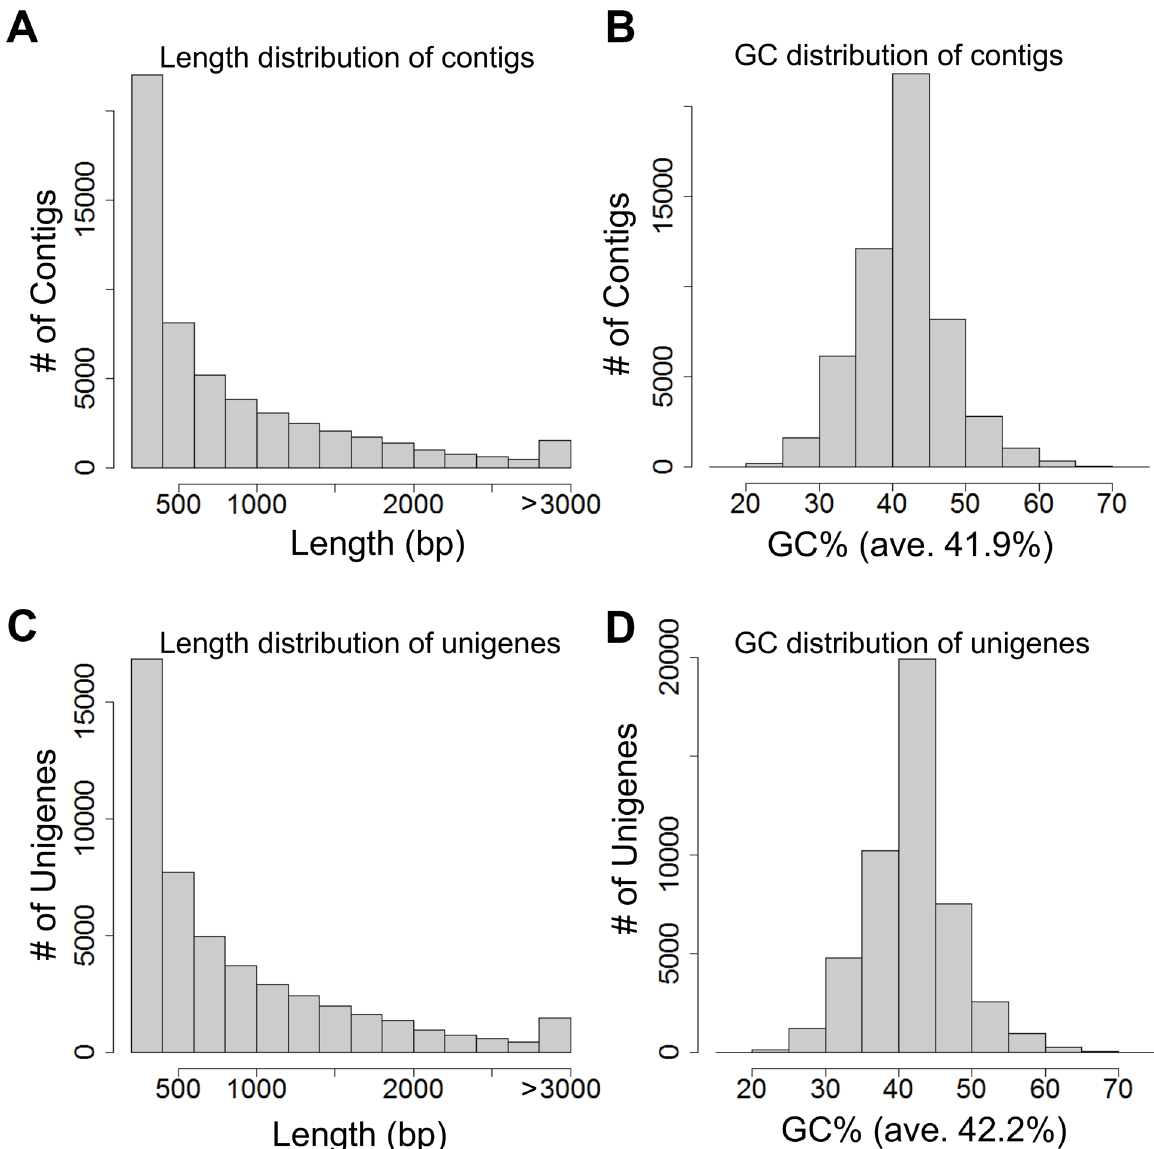
Fig 1. Overview of the de novo transcriptome assembly in Perilla frutescens purpurea (red perilla). (A and B) Length and GC distribution of contigs assembled from high-quality clean reads by the Trinity program [27]. (C and D) Length and GC distribution of unigenes generated from further contig assembly.